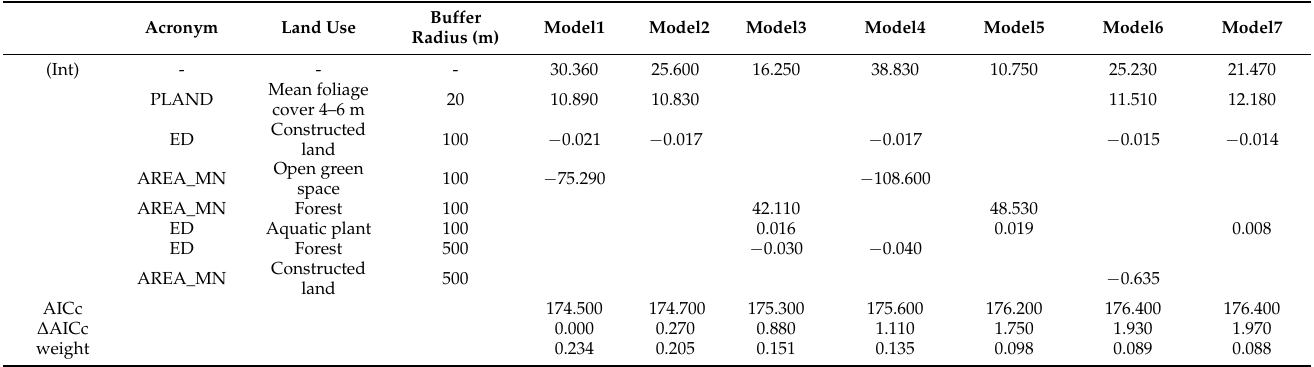
Table 2. The top model set connected landscape- and patch-level variables and bird species richness, with ∆ AICc < 2 and the number of predictors ≤